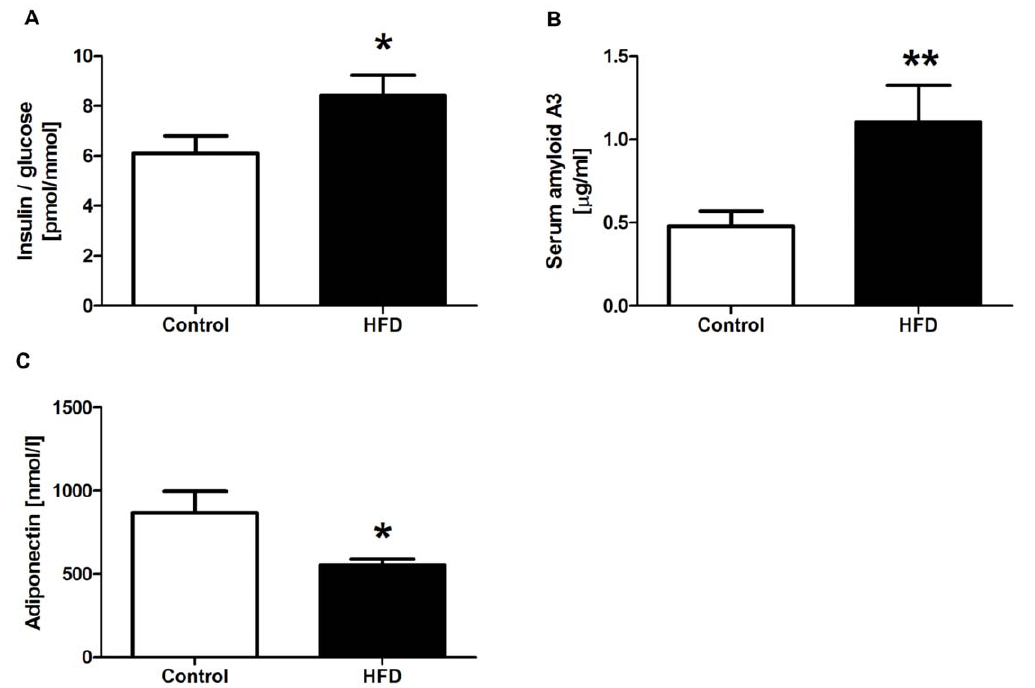
Figure 1. Serum biochemical analyses. Insulin/glucose ratio (A), concentrations of serum amyloid A3 (B) and adiponectin (C) in control and high saturated fat diet (HFD) fed mice (n=15–16 per group). Data are shown as mean 6 SEM. ** P , 0.01 and * P , 0.05 compared to control. 16S rDNA. Modified versions of primers F939 (5 9 TTGACGGGG- GCCCGCAC3 9 ) and R1492 (5 9 ATTAGATACCCNGGTAG3 9 )